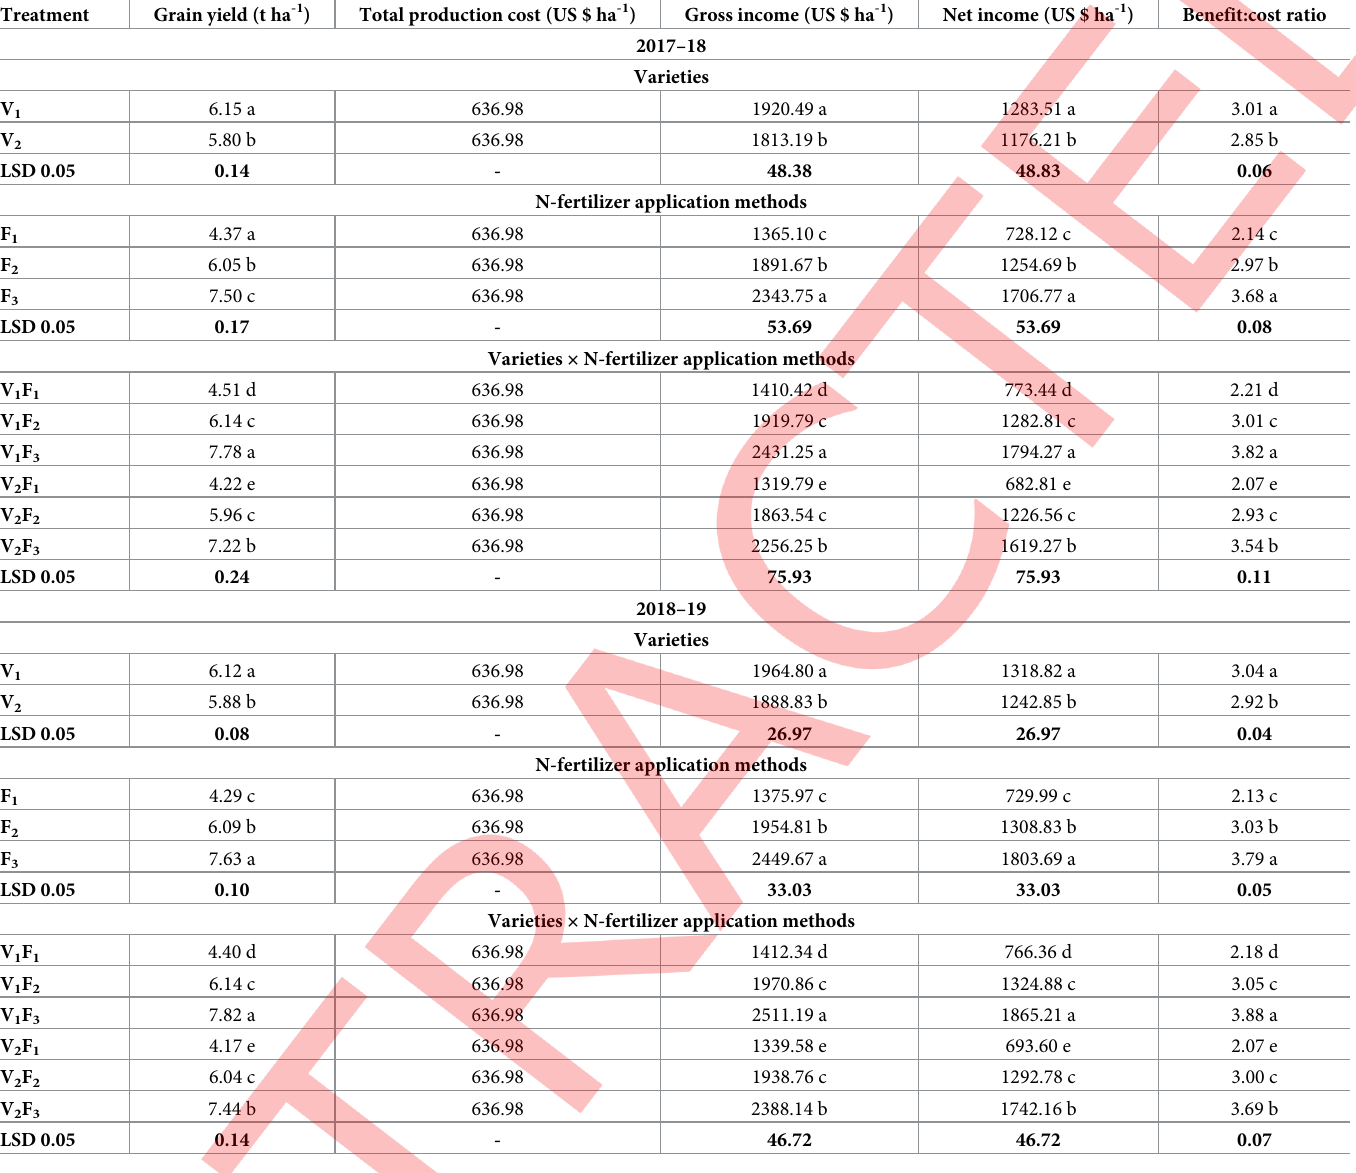
Table 4. The impact of nitrogen fertilizer application methods on yield and economic returns of transplanted fine rice. Treatment Grain yield (t ha -1